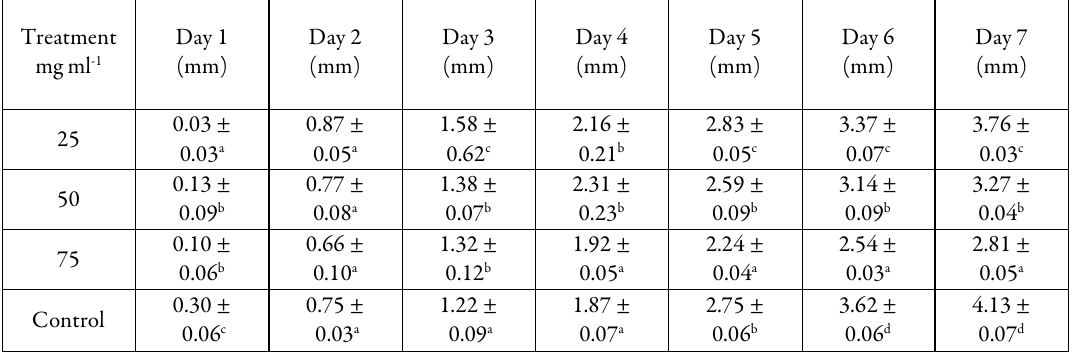
Table 3. In vitro inhibitory effect of A. wilkesiana aqueous leaf extract on the mycelial growth of R. solani Treatment mg ml